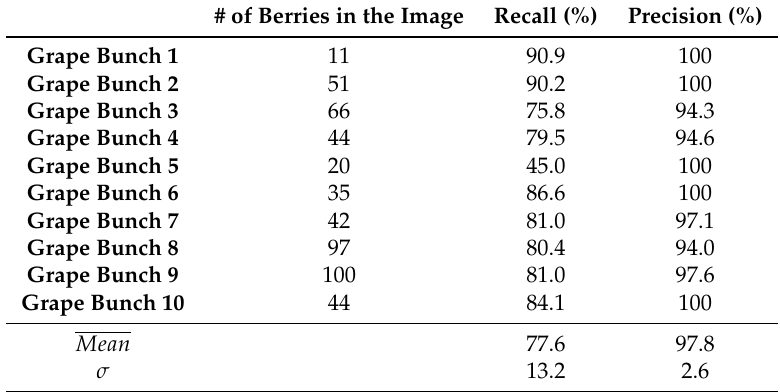
Table 6. Berry recall and precision for the berry yield parameter on 10 grape bunches of a VSP trellis grapevine row.